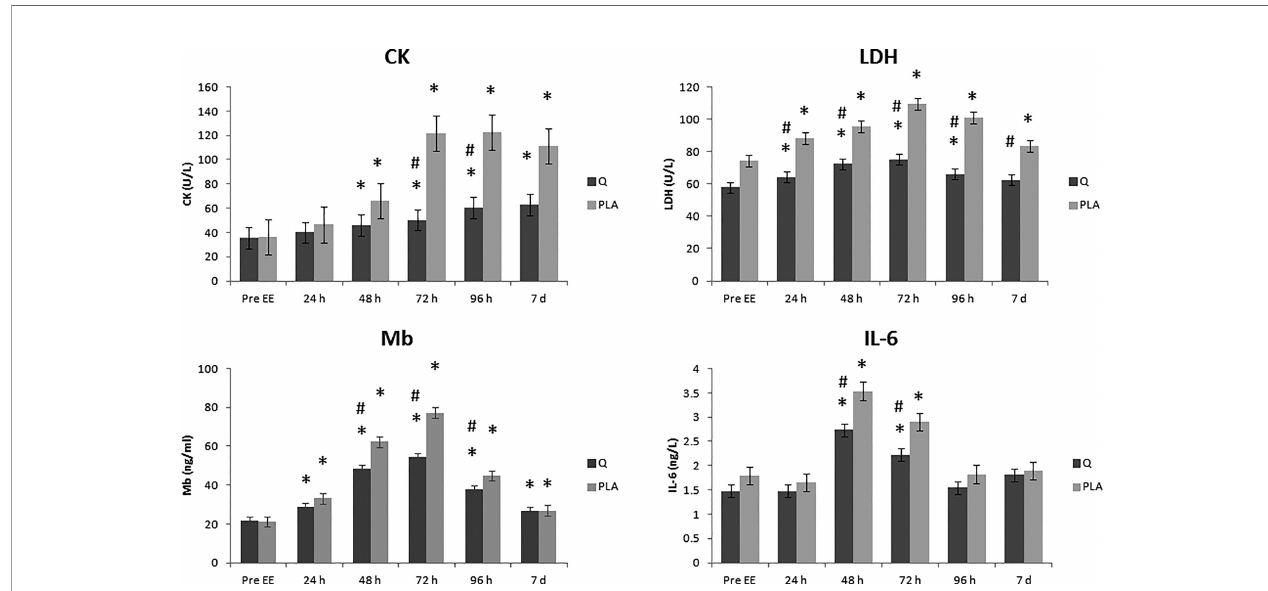
FIGURE 2 | Effect of quercetin supplementation on creatine kinase (CK), lactate dehydrogenase (LDH), myoglobin (Mb) and Interleukin-6 (IL-6) plasma levels. The levels of creatine kinase (CK), lactate dehydrogenase (LDH), myoglobin (Mb) and Interleukin-6 (IL-6), were measured in plasma of quercetin/placebo supplemented subjects before the eccentric exercise (Pre EE) and after 24, 48, 72 and 96 hours (24 h – 96 h) and after 7 days (7 d) recovery time. Values are expressed as means ± pooled SEM. n =12 for each group. *P < 0.05 vs Pre EE and # P < 0.05 vs